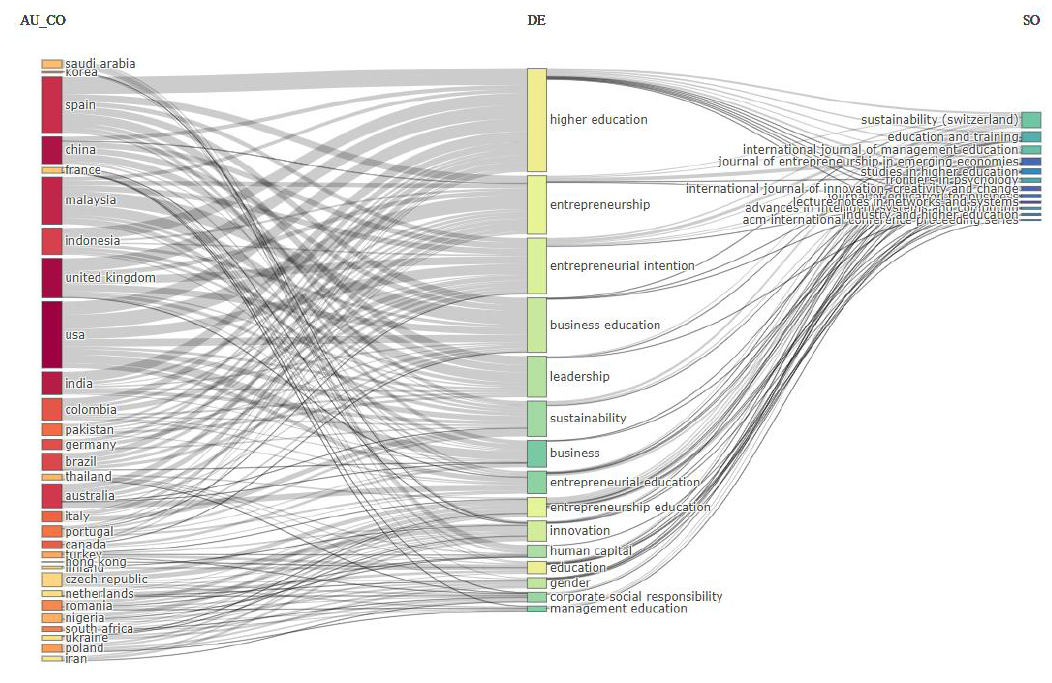
Figure 1. Three-Field Plot